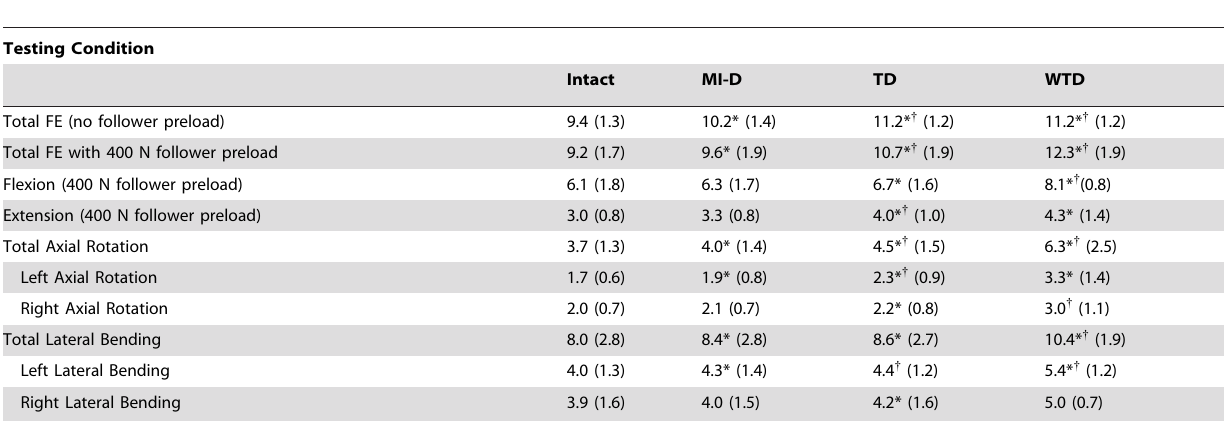
Table 2. L4–L5 range of motion (in degrees), corresponding to a moment of 8 Nm in flexion and 6 Nm in extension, 6 6 Nm in lateral bending, and 6 5 Nm in axial